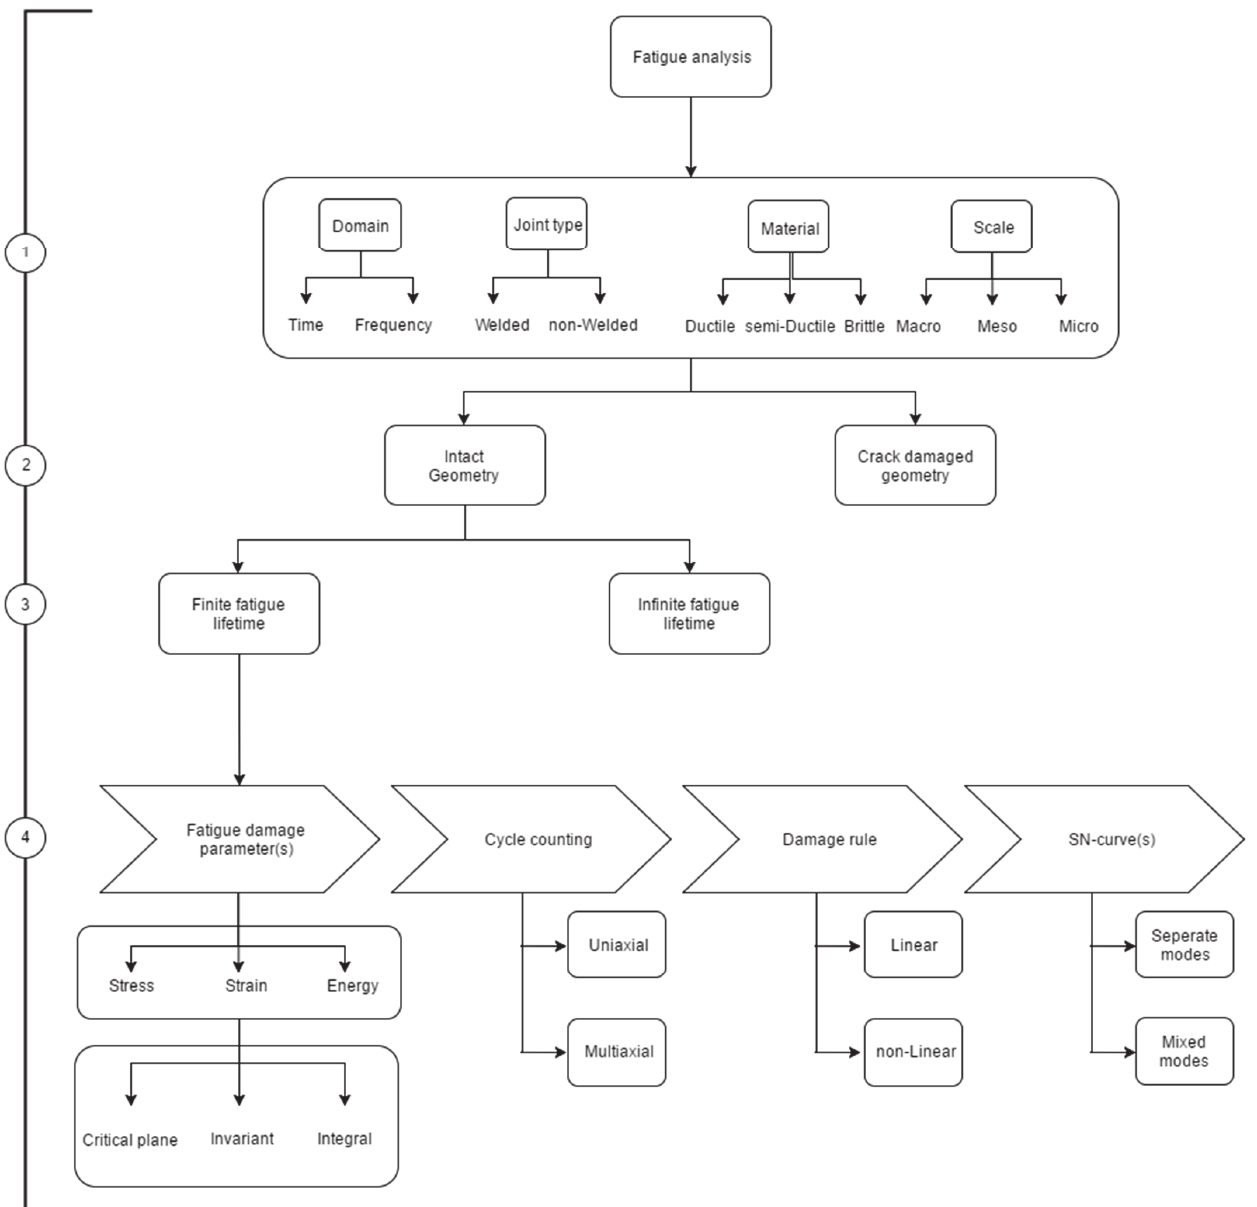
Figure 1: Overview of the four elementary levels in a multiaxial fatigue